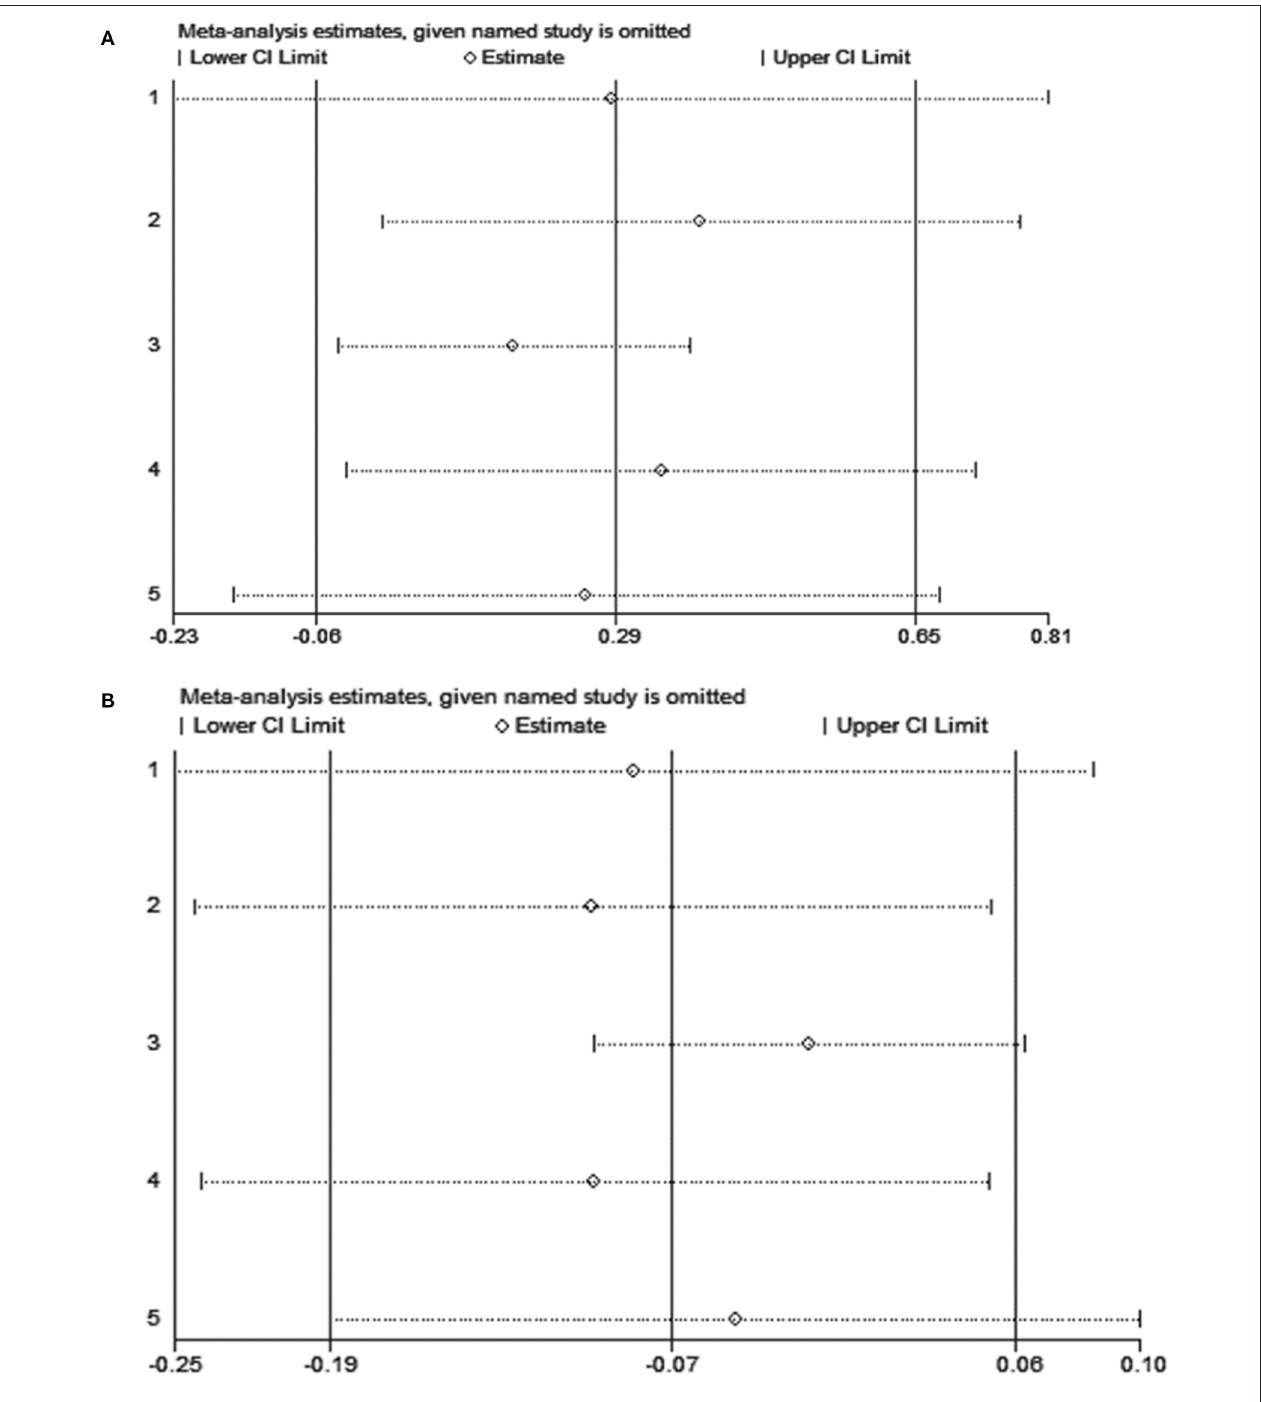
FIGURE 3 | (A) Sensitivity analysis for CHO-O; (B) Sensitivity analysis for